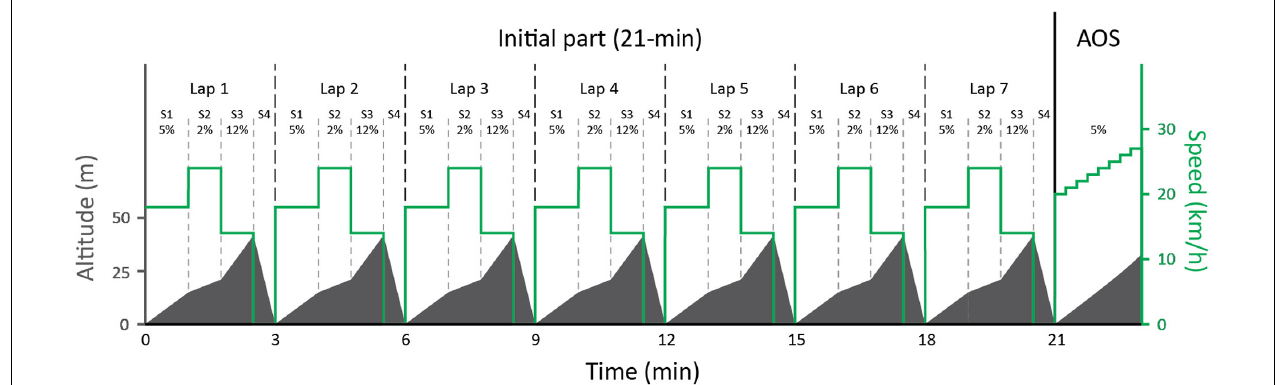
FIGURE 1 | Protocol showing the changes in altitude and speed for the simulated mass-start competition divided into a 21-min initial part with seven 3-min laps where each contains 4 segments (S), followed by an all-out incremental sprint (AOS) with gradually increased speed each 15 s until exhaustion. Although the track was designed for the use of specific sub-techniques in each segment, the skiers could freely select sub-techniques themselves during the entire